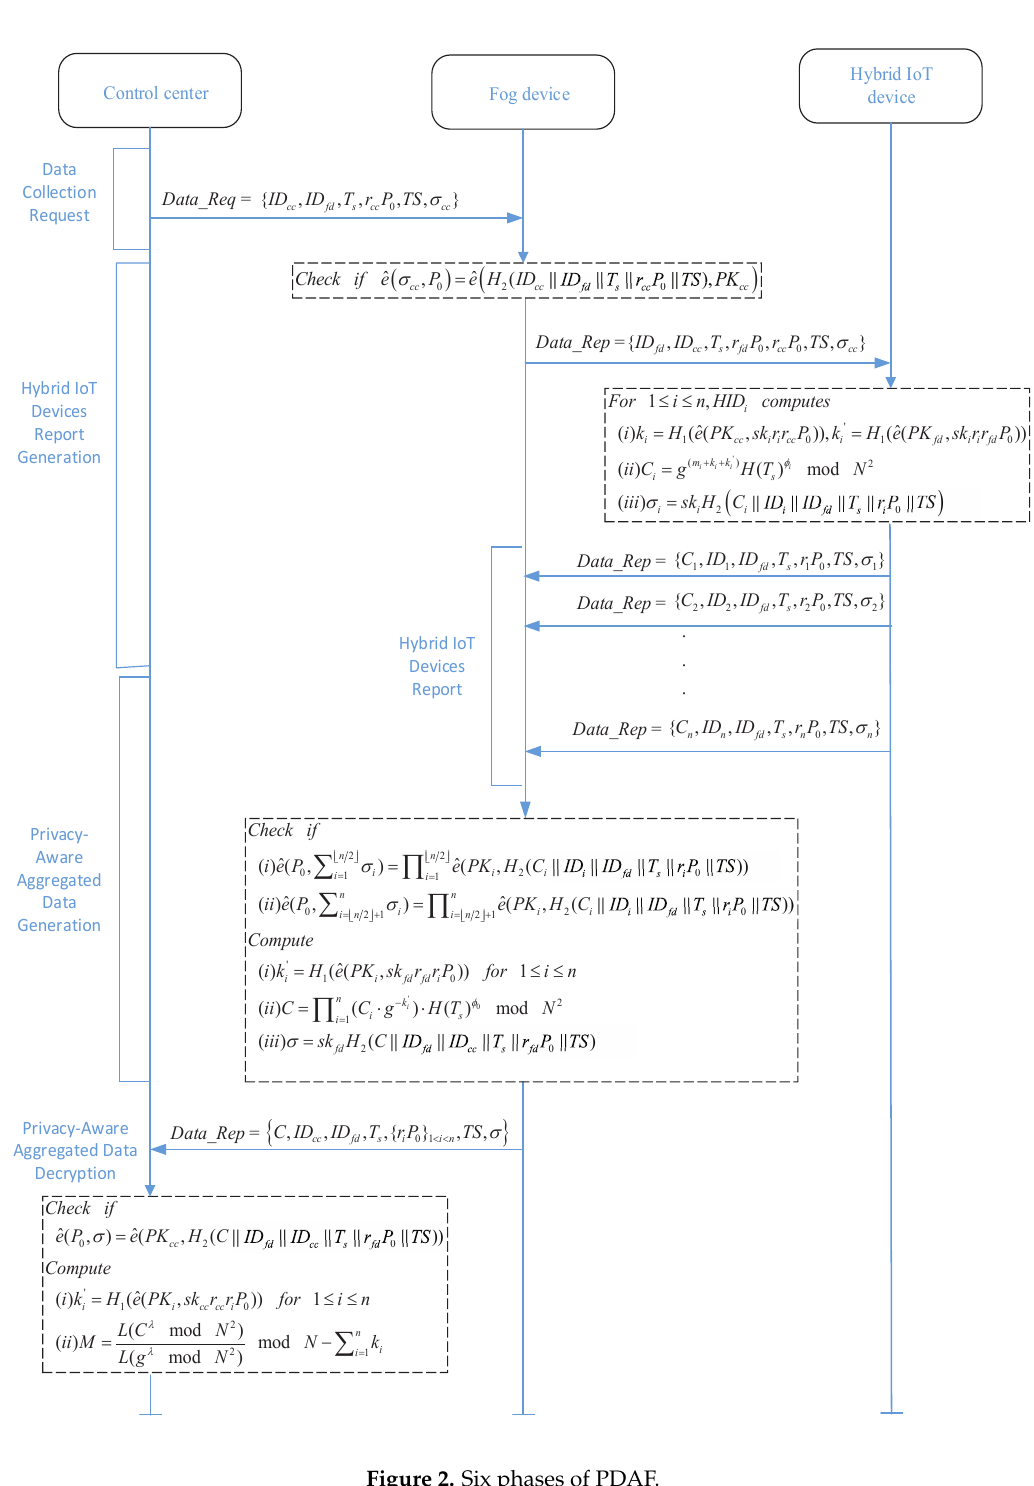
Figure 2. Six phases of